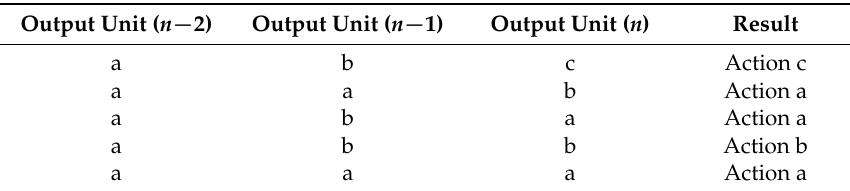
Table 1. Real-time test result estimate